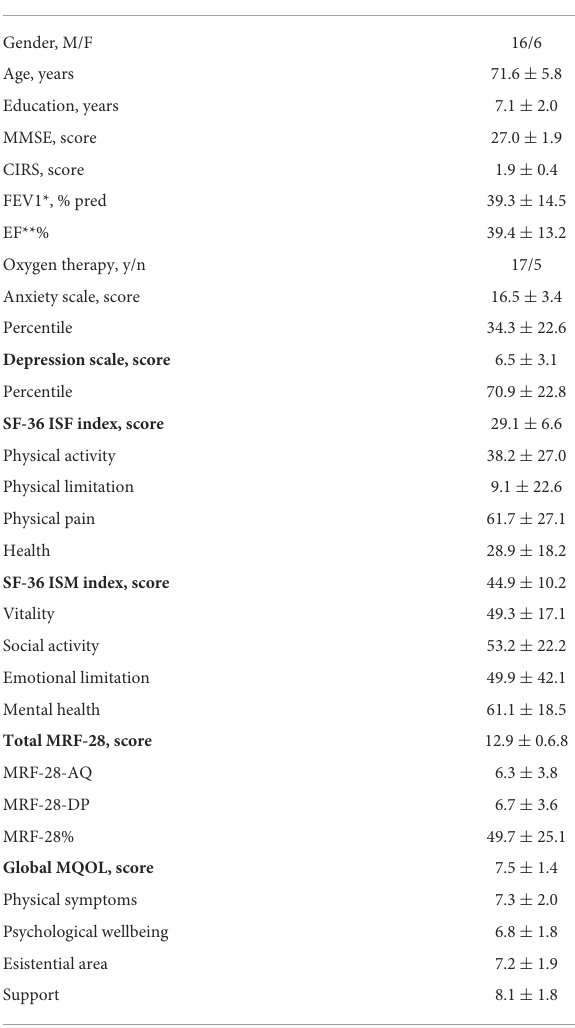
TABLE 1 Clinical characteristics and evaluations in patients at admission (T0) to the telepsychology service. Patients at T0 ( n = 22)